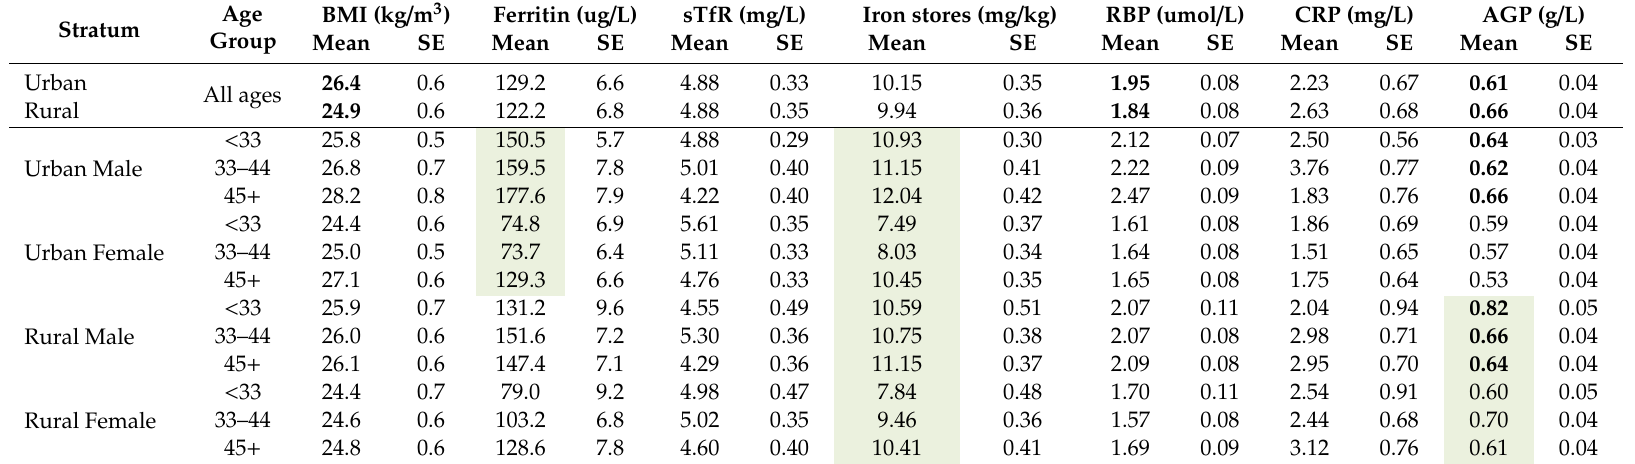
Table 5. Estimated marginal means of body mass index and serum biomarker concentrations by urbanicity and